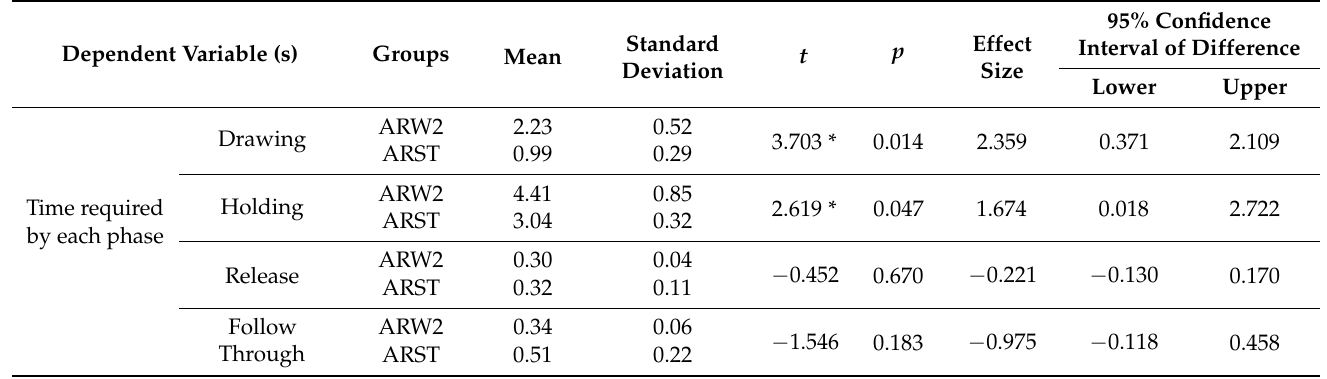
Table 3. Time required by each phase.